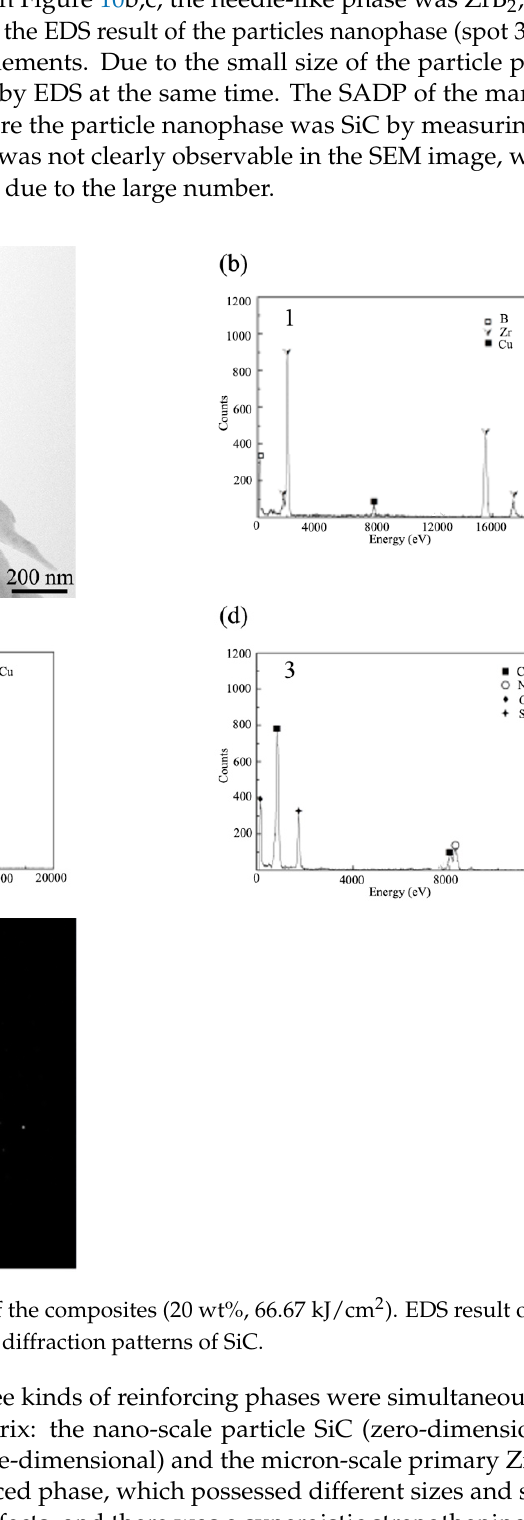
Figure 9. ( a ) TEM images of the composites (20 wt%, 66.67 kJ/cm 2 ). ( b ) Selected area diffraction patterns of ZrB 2 . ( c ) High-resolution TEM of the interface of ZrB 2 with Cu matrix.